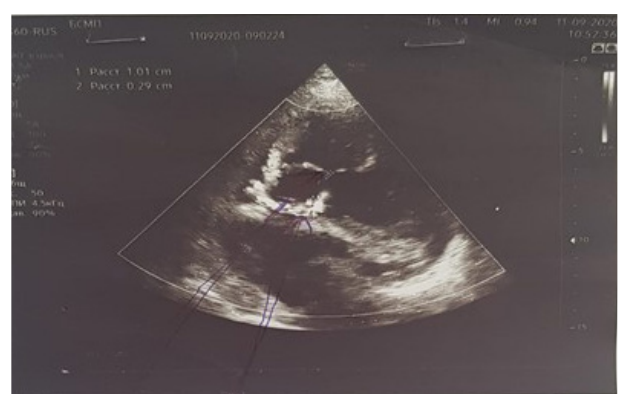
Fig. 1 - Echocardiography before